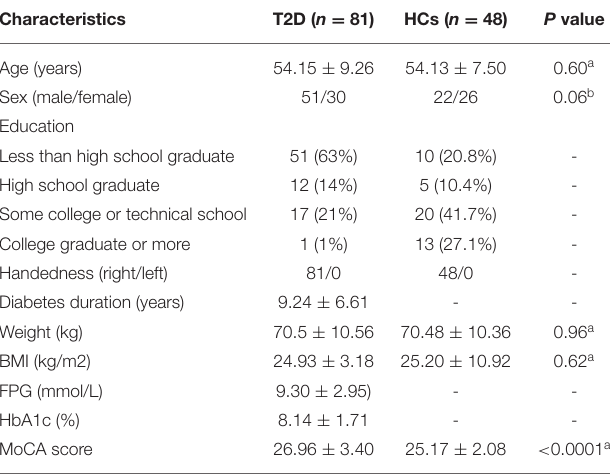
TABLE 1 | Demographics clinical characteristics of the participants.